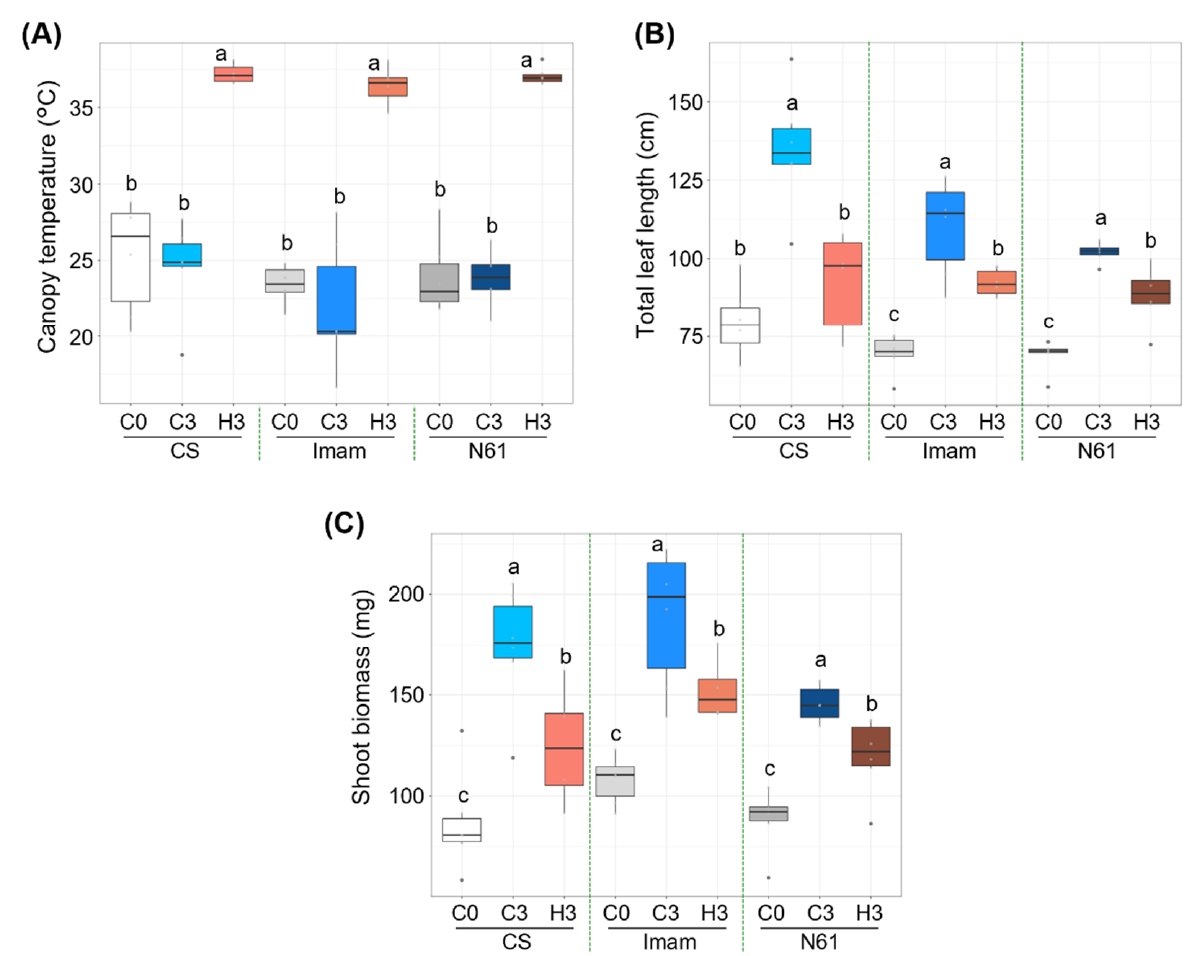
Figure 1. Effect of heat stress on the growth of wheat genotypes Chinese Spring (CS), Imam, and Norin 61 (N61). ( A ) Canopy temperature, ( B ) total leaf length, and ( C ) shoot biomass for (C0) before heat treatment, (C3) control plants after three days, and (H3) plants exposed to heat for three days. Six plants were used for each measurement. One-way ANOVA with post-hoc Tukey HSD test ( p < 0.05) was carried out for statistical analysis within a given genotype.